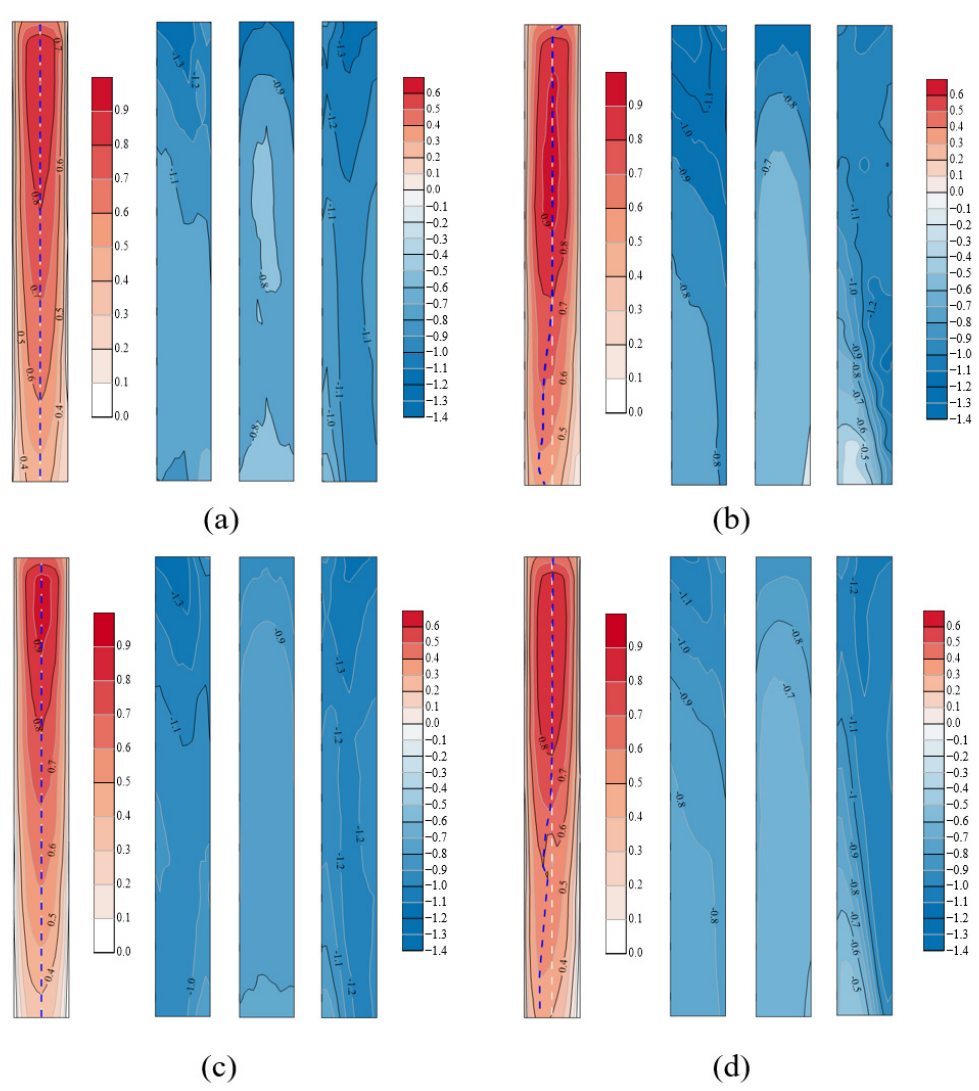
Figure 6. Distributions of C p : ( a ) CWF1-0 ◦ ; ( b ) TWF30-0 ◦ ; ( c ) CWF2-0 ◦ ; and ( d ) TWF20-0 ◦